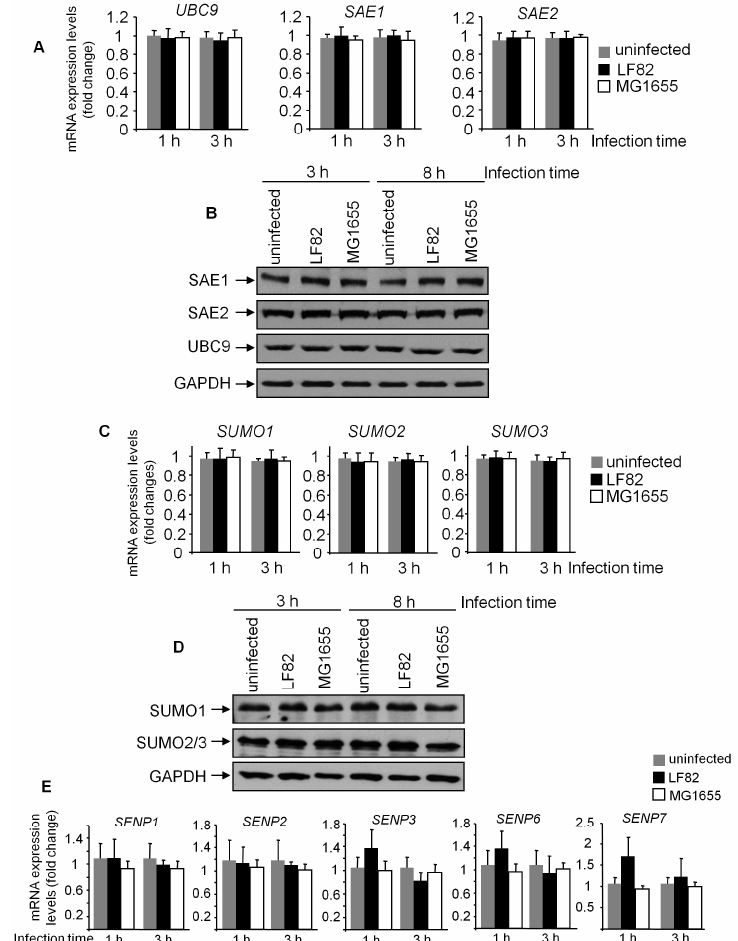
Figure 5. AIEC infection does not modify expression levels of SAEs, UBC9, SUMOs and SENPs. T84 cells were infected with the AIEC LF82 or the non-pathogenic E. coli MG1655 strain for the indicated time. mRNA expression levels of SAE1 , SAE2 , UBC9 ( A ), SUMO s, ( C ) as wells as SENP s ( E ) were analyzed by qRT-PCR. ( B , D ) Protein levels of SAE1, SAE2, UBC9, ( B ) as well as SUMOs, ( D ) were analyzed by Western blot. Data are means ± SEM of three replicates, and representatives of three independent experiments.